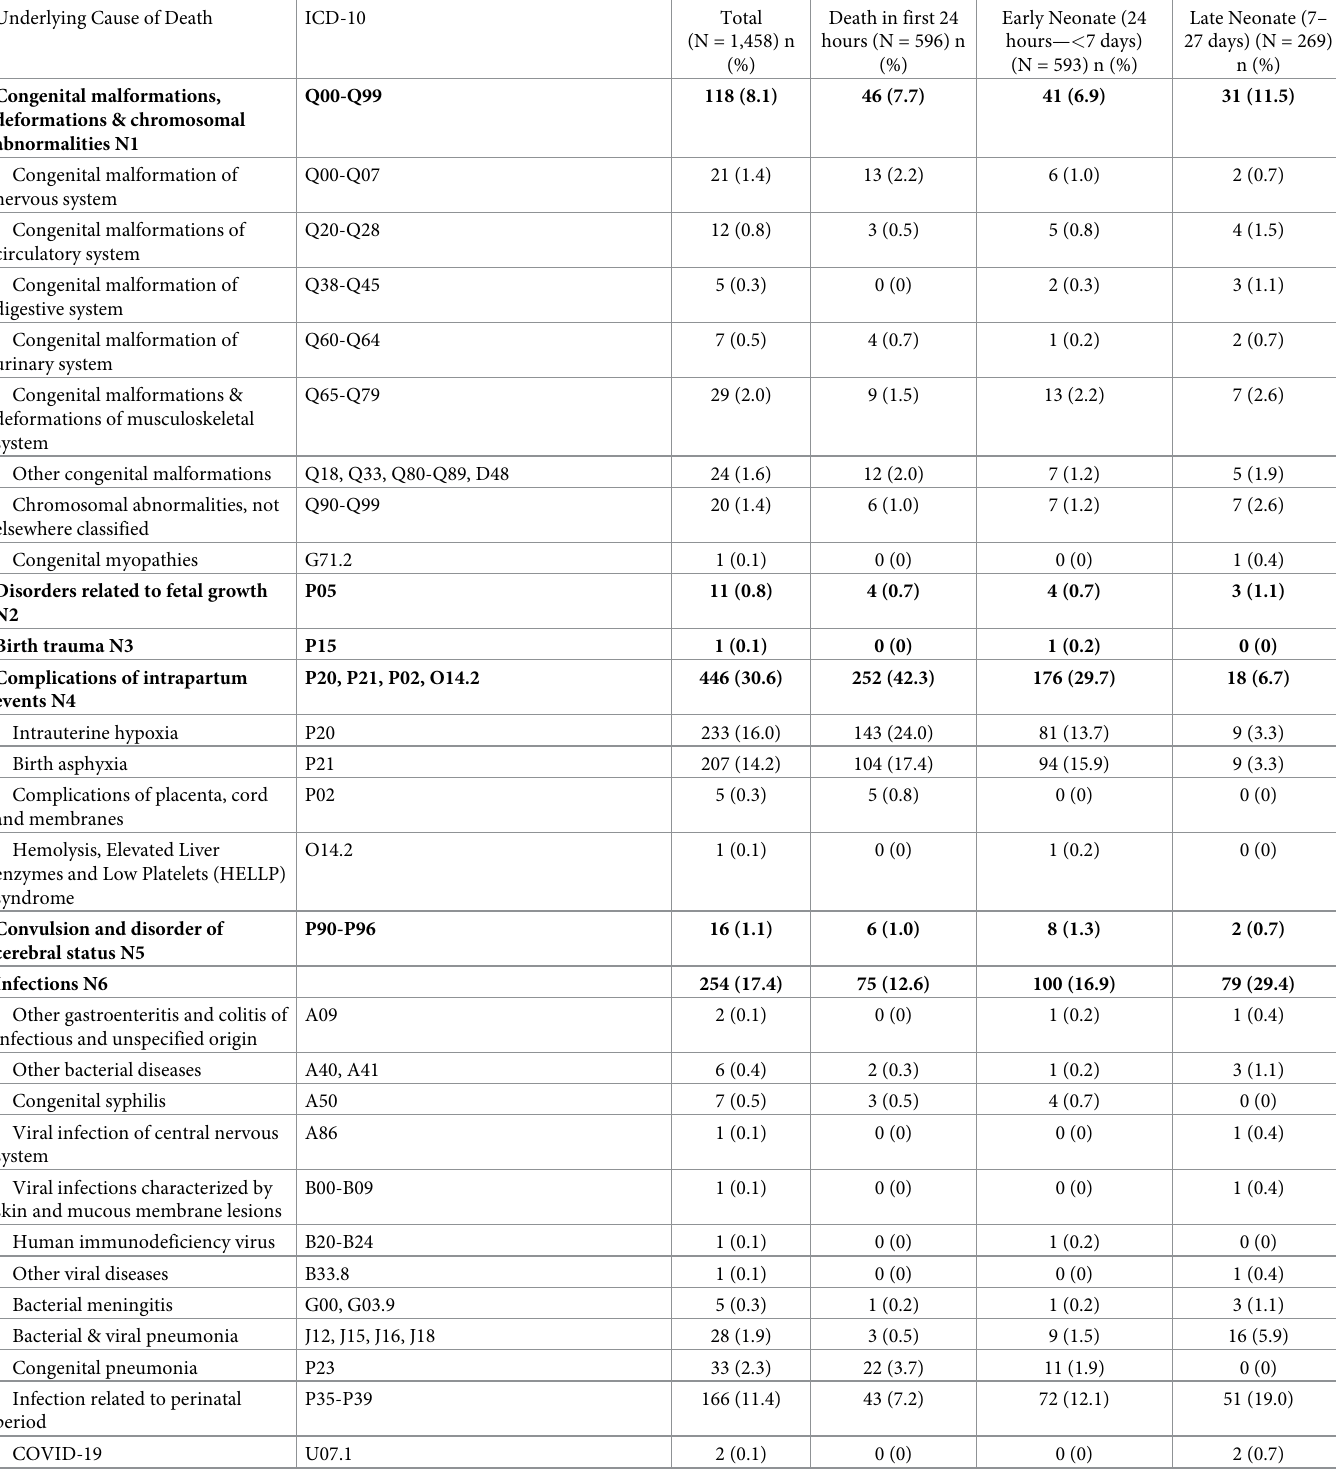
Table 2. Underlying causes of death for newborn deaths enrolled in CHAMPS, by age at death and WHO ICD 10 Perinatal Mortality (PM) category (2016–2021). Criteria used to define each cause available at: